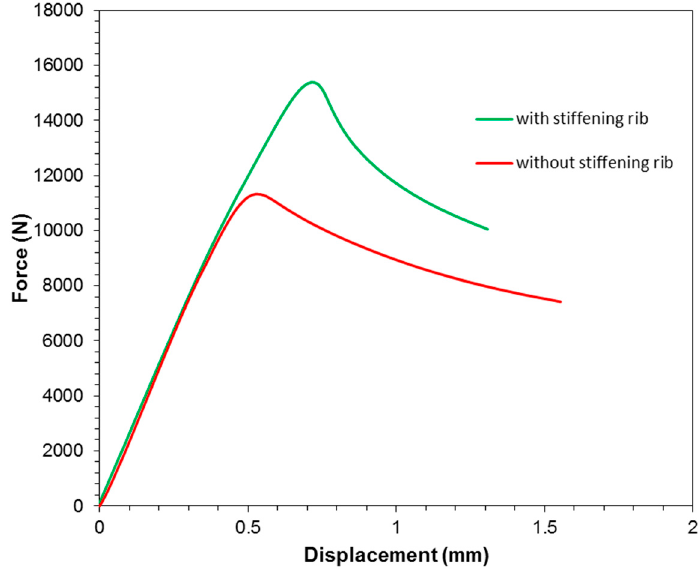
Figure 24. Force–displacement curves obtained from the uniaxial compression test of panels.